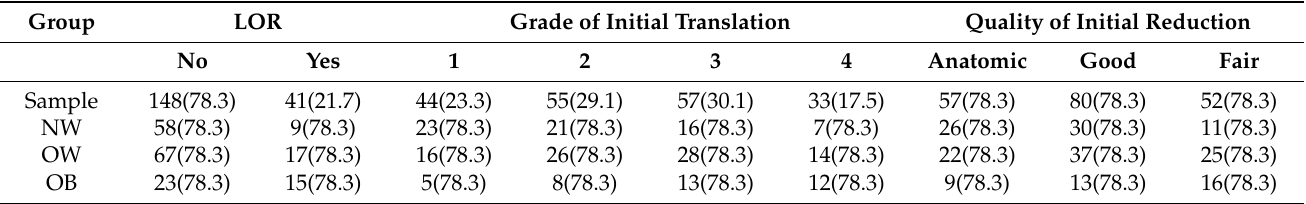
Table 2. Loss of reduction (LOR), grade of initial translation, and quality of initial reduction for each